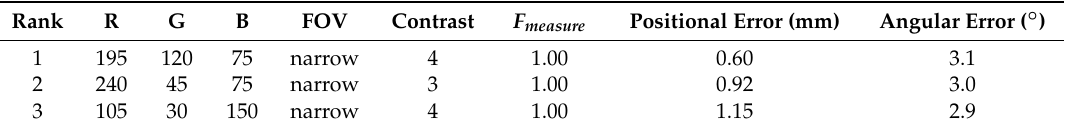
Table 4. Best-three designs of Condition II.